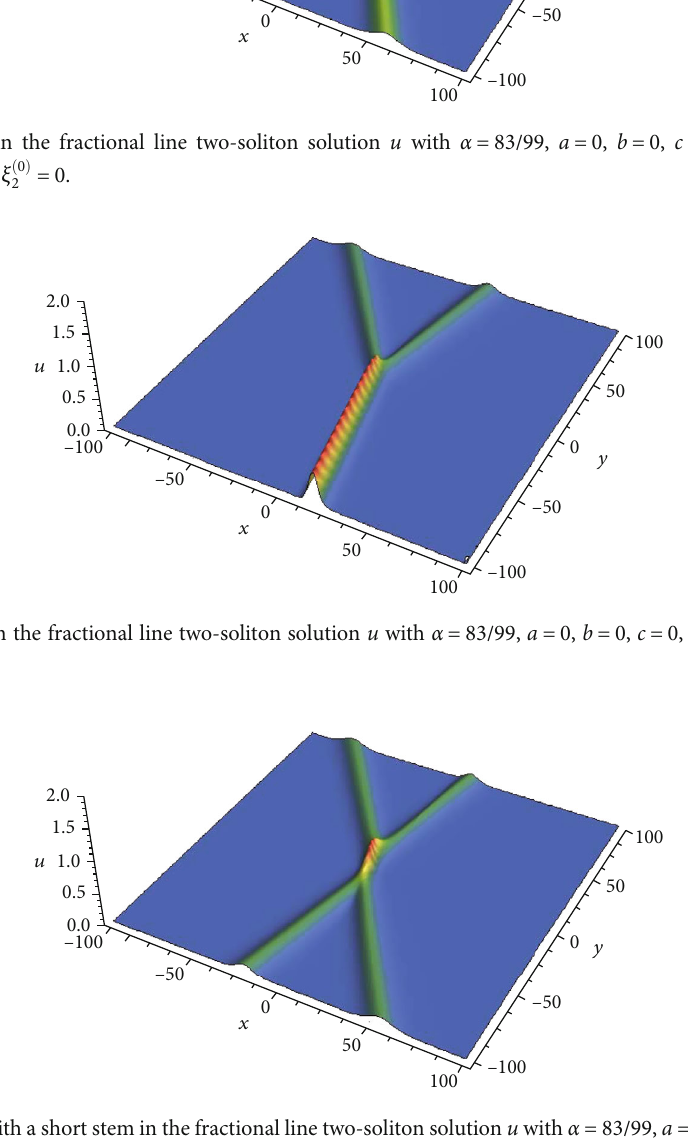
0 Þ = 0 , and ξ ð 0 Þ = 0 1 2